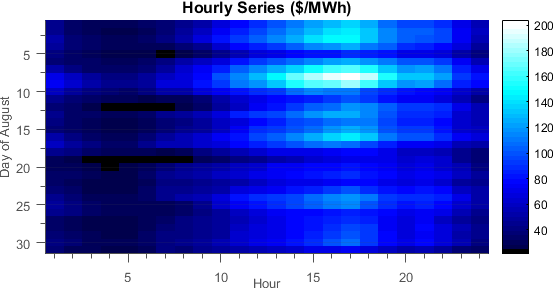
Figure 3. The hourly price series used for August